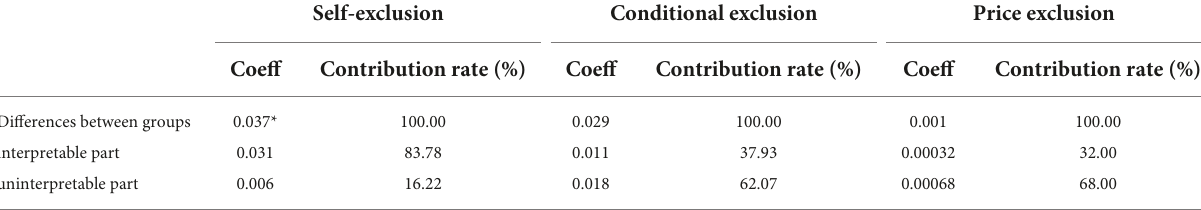
TABLE 7 Contribution